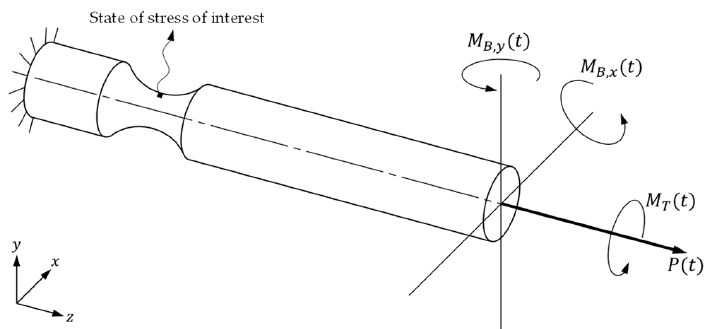
Figure 2. Notched cantilever cylindrical specimen under axial P ( t ) ; torsion M T ( t ) ; and two bending moments, M B , x ( t ) and M B , y ( t ) , applied at the free end.